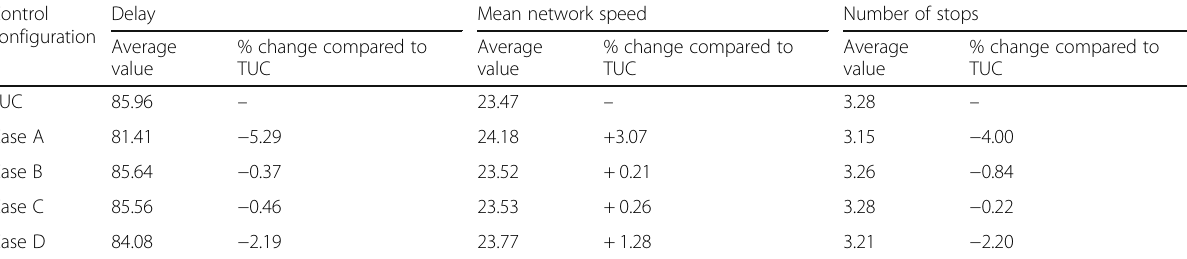
Table 2 Simulation results for demand scenario 2 (dense traffic conditions) Control Delay configuration